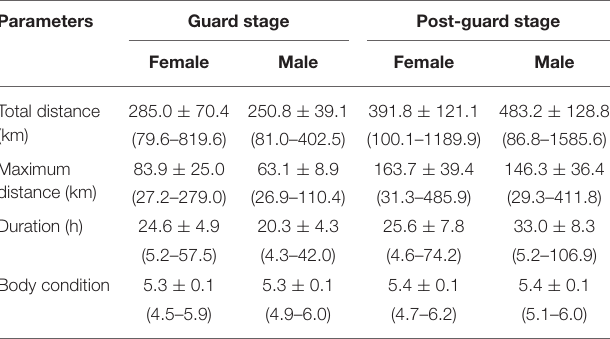
TABLE 4 | Foraging trip parameters and body condition of female and male Cape gannets attending chicks during the guard and post-guard stages of chick rearing in the 2015/16 breeding season at Bird Island, Algoa Bay.